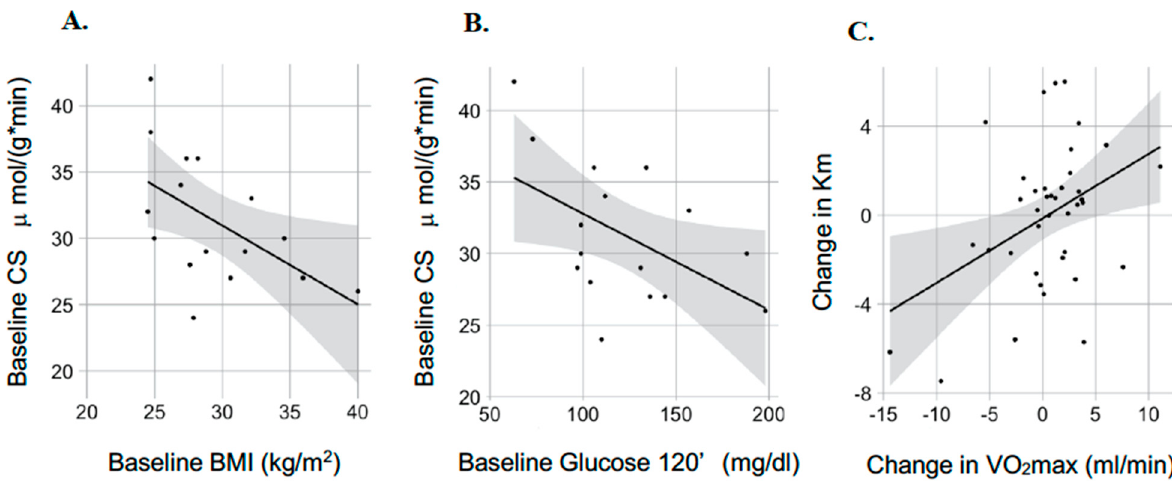
Figure 3. Pairwise correlations among clinical features and parameters of mitochondrial respiration in skeletal muscle. ( A ). Correlation between Citrate Synthase (CS) activity and Body Mass Index (BMI). ( B ). Correlation between Citrate Synthase (CS) activity and glucose concentration at 120-min of OGTT (glucose-120 ′ ). ( C ). Correlation between changes in Km for succinate titration and changes in VO 2max under the intervention.* means multiplication.